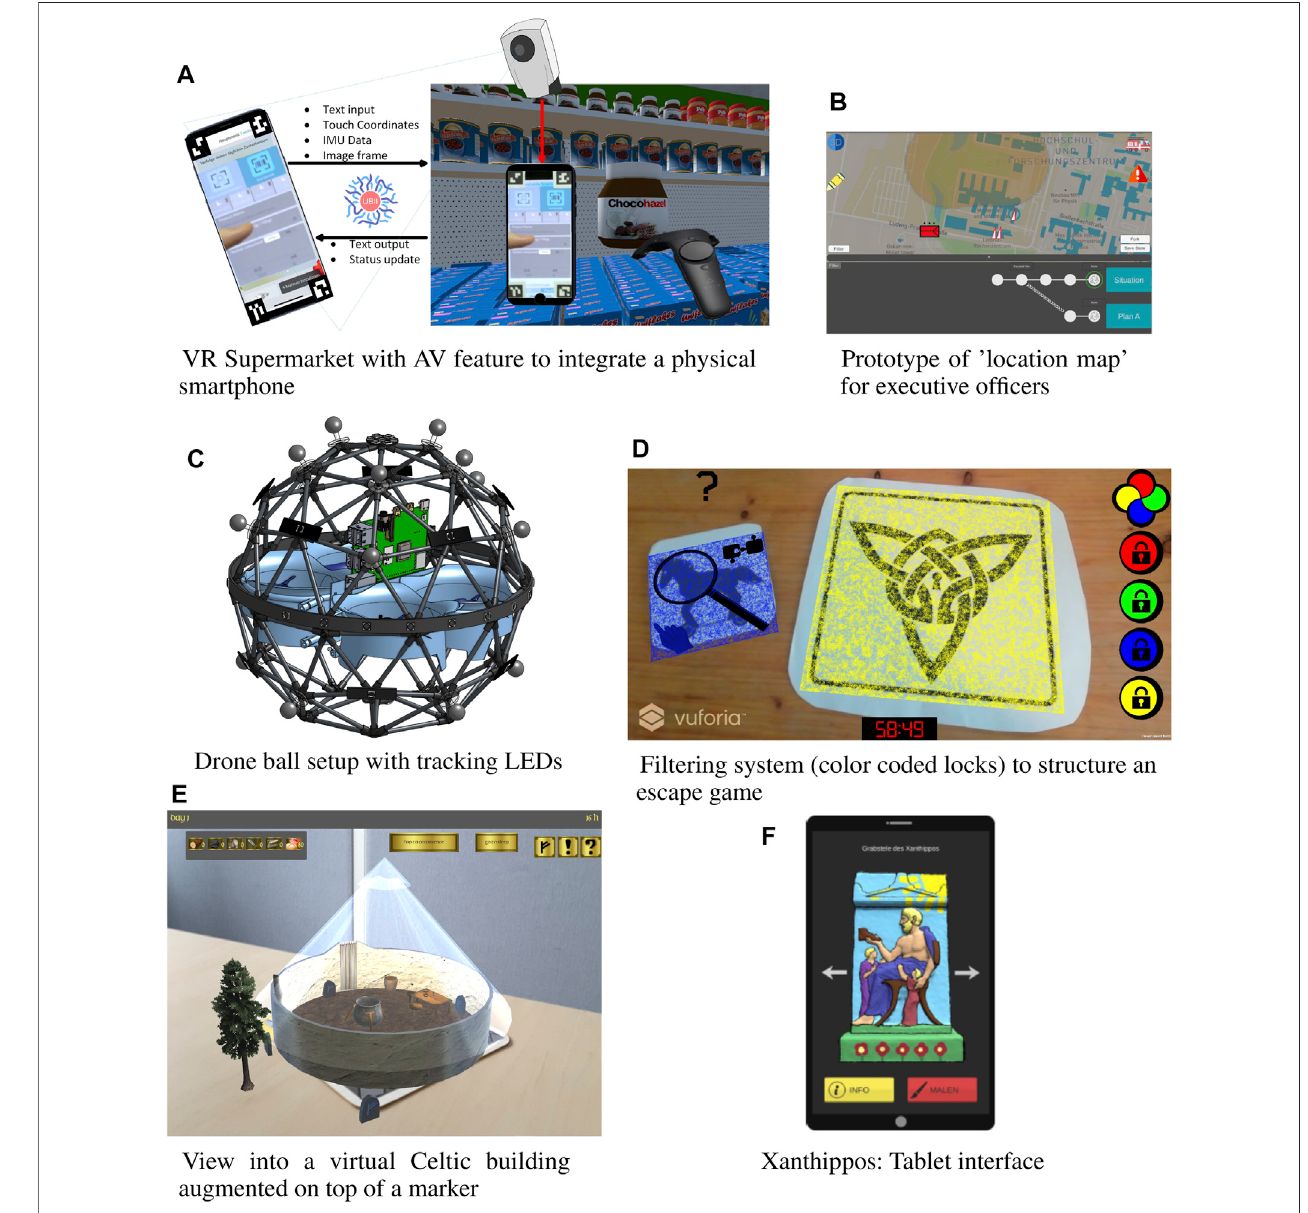
FIGURE 5 | Example applications for different MR scenarios to explore requirements for the presented frameworks.